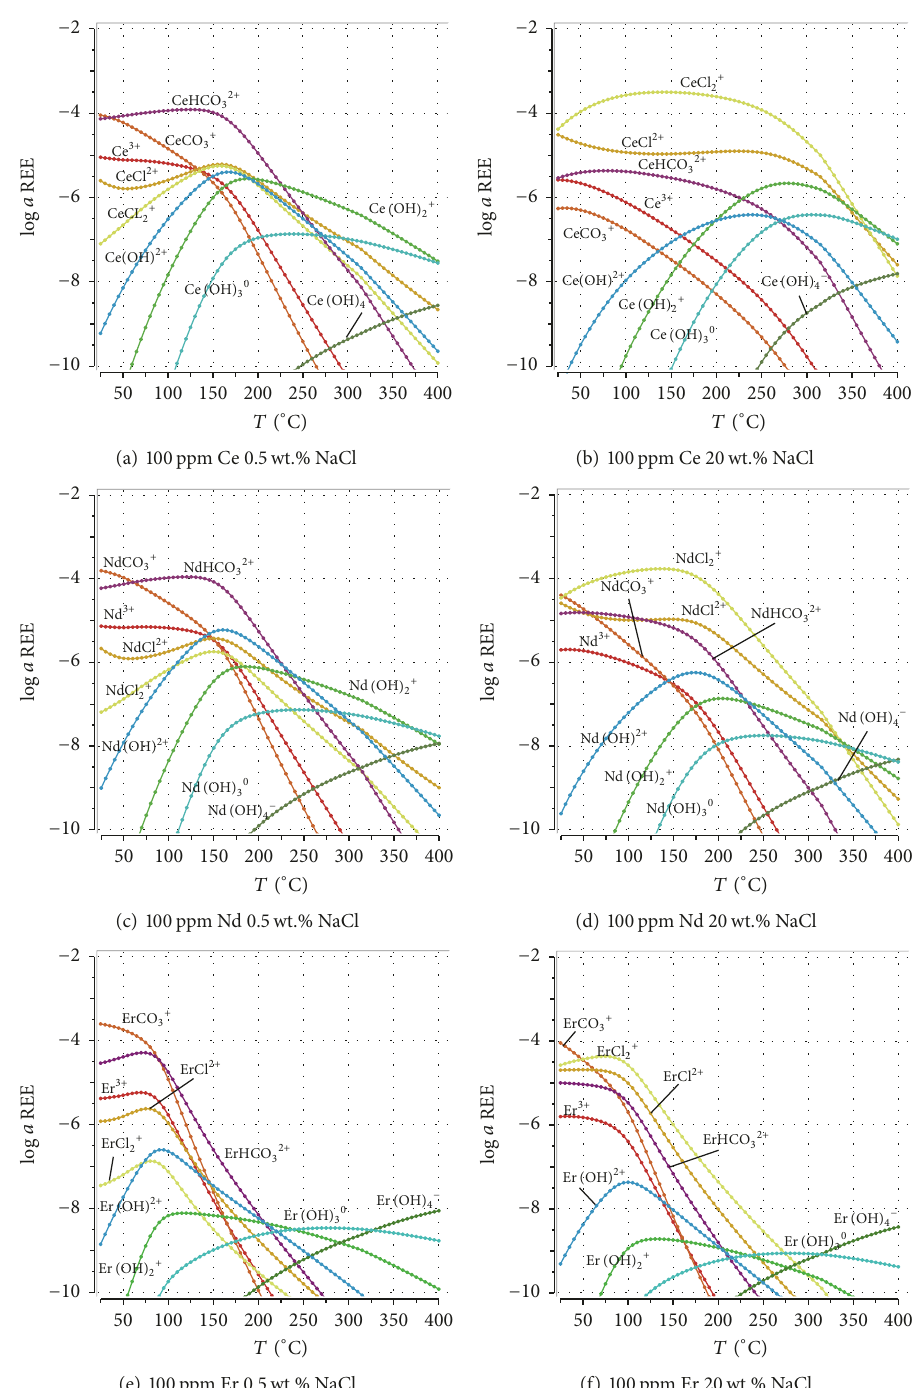
Figure 5: Rare earth element fluid-calcite partitioning Model IIb at 1kbar, showing the speciation of REE in a fluid in equilibrium with REE- bearing calcite as a function of temperature and salinity (0.5 and 20wt.% NaCl). The starting fluid had a composition of 100 ppm REE, 𝑋 CO 2 of 0.1, and 50 g of